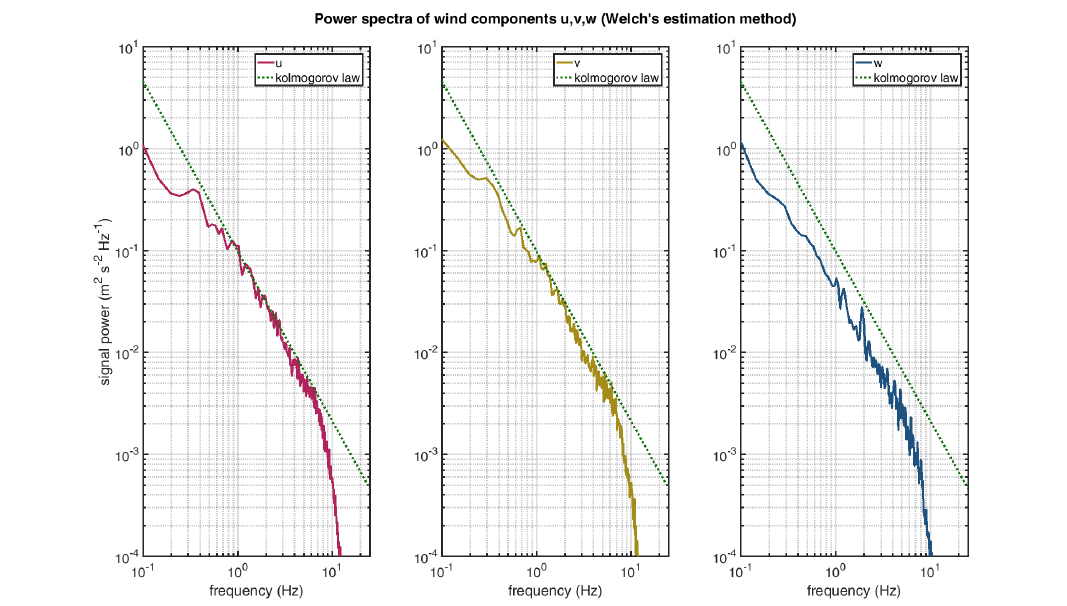
Figure 10. Power spectra of wind components using the method of Welch [43] compared to the power law for the inertial subrange of locally isotropic turbulence developed by Kolmogorov [39]. The data were gathered on 2, 10 and 11 of July 2016 in Savè (Collines, Benin) during the project DACCIWA [27]. Spectra of different straight legs on different days were averaged according to Welch